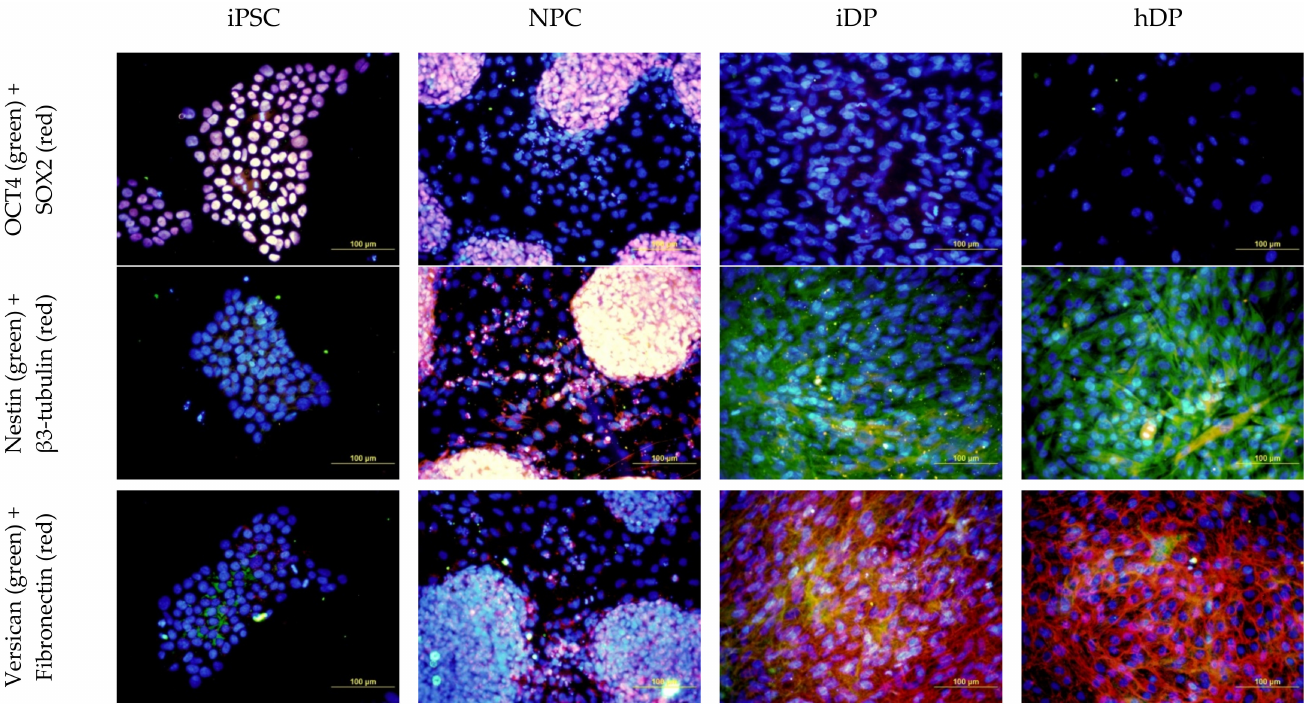
Figure 2. Analysis of the expression of specialized markers in iPSC, NPC, iDP, and hDP cell lines: OCT4 (green), SOX2 (red); NESTIN (green), β 3-TUBULIN (red); VERSICAN (green), FIBRONECTIN (red). Fluorescence microscopy, the scale length in all pictures is 100 µ